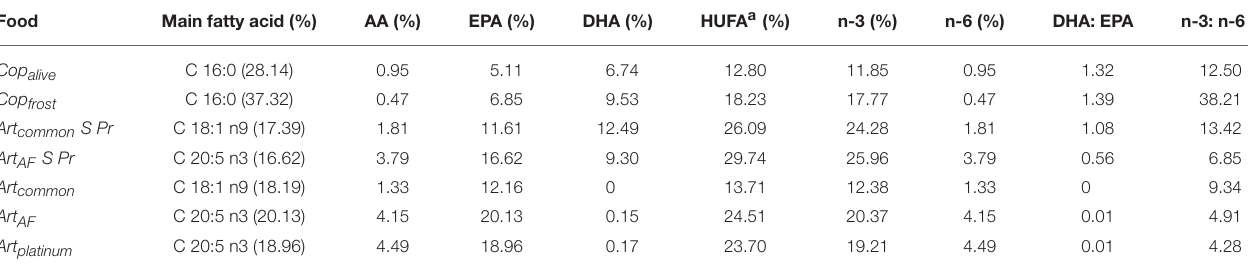
TABLE 3 | Percentages and ratios of selected fatty acids within different animal feeds of Hippocampus reidi . Food